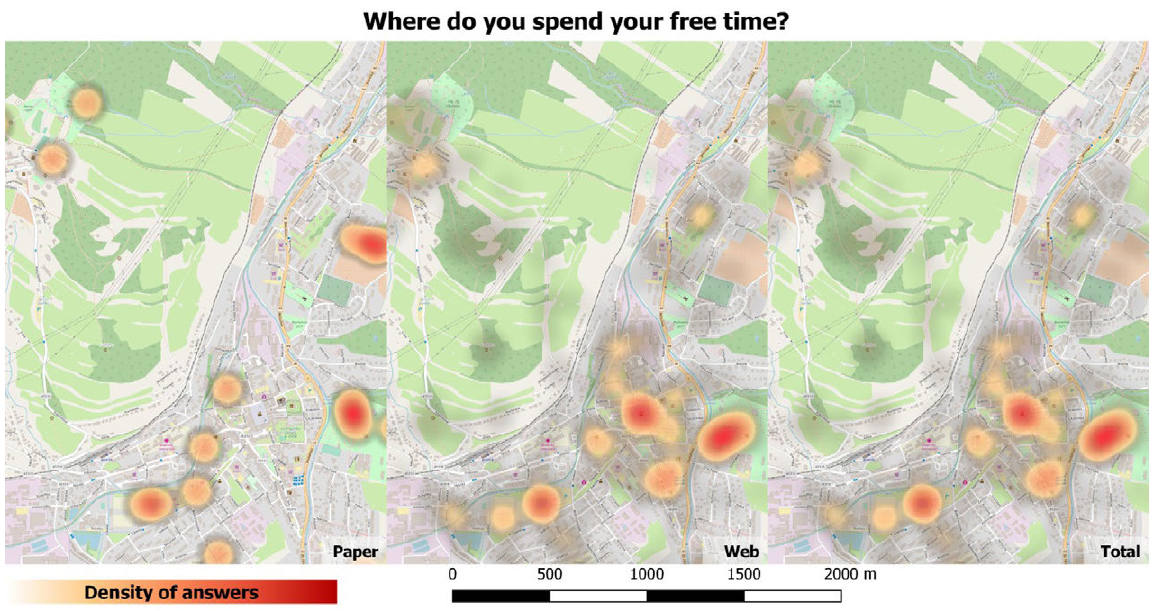
Fig. 9. Where do respondents spend their free time in